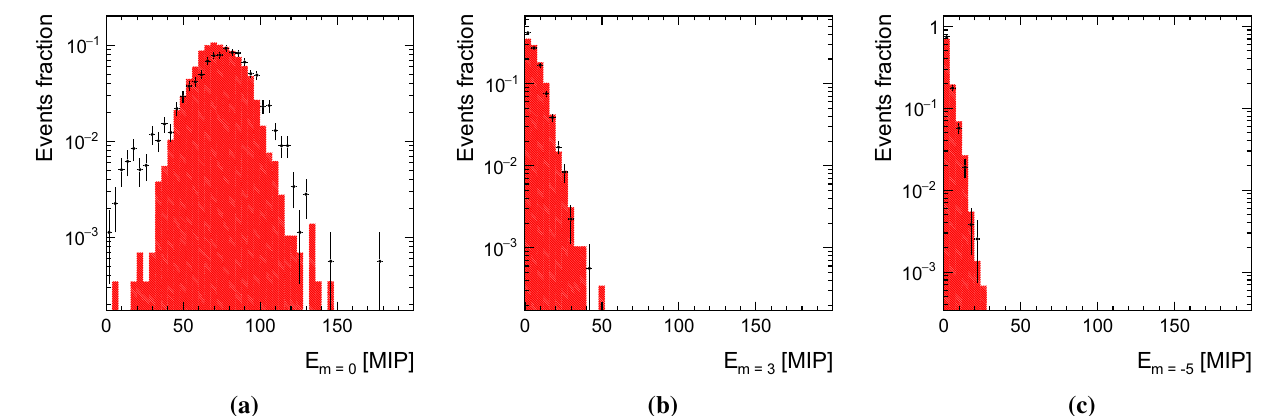
Fig. 23 Sum of the deposited energy distribution from configuration 2, in MIP units, for the radial pads with index m = 0, 3 and − 5 from the shower core at ( a ) ( b ) and ( c ), respectively. The data (dots) are compared to the MC simulation (shaded area)